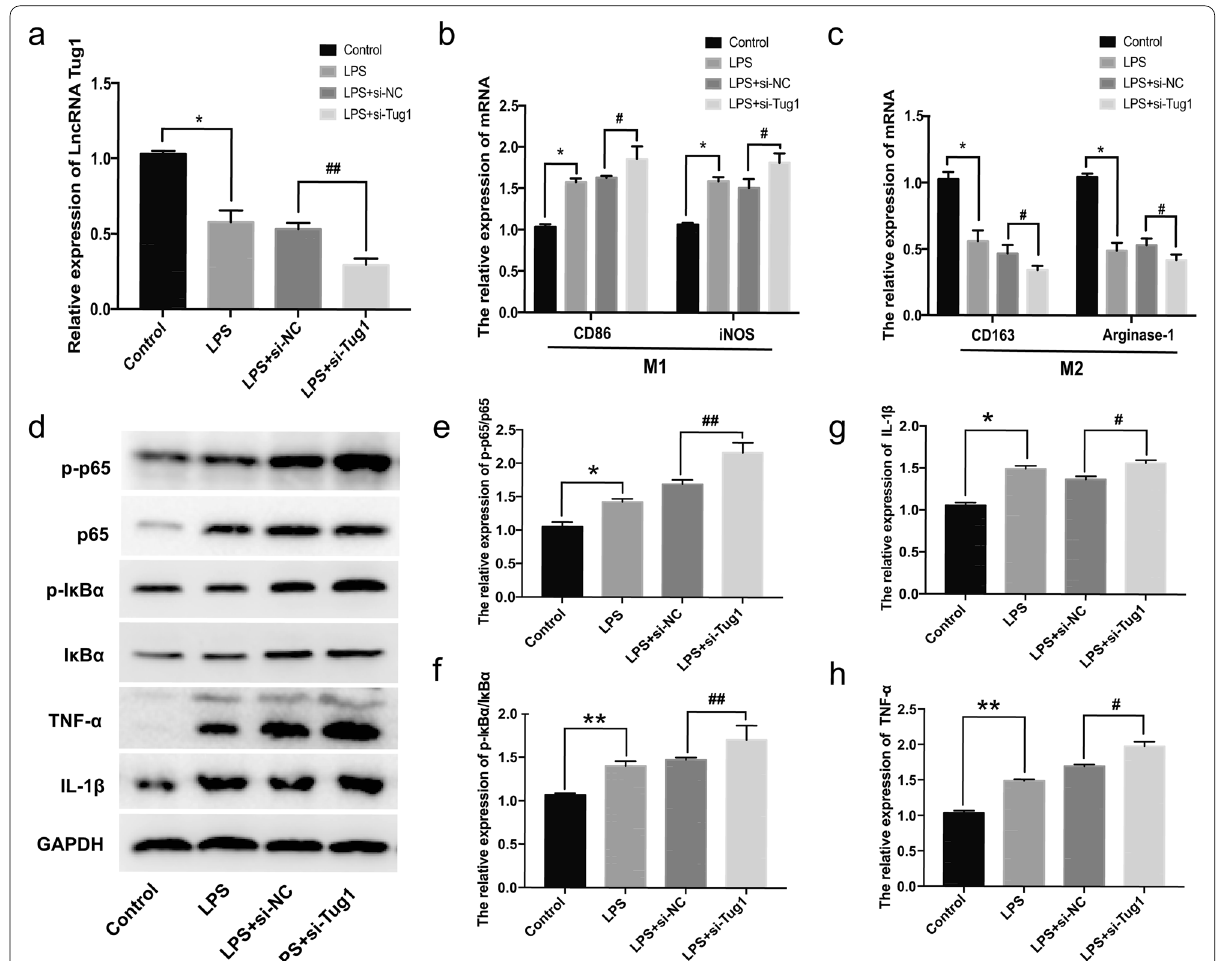
Fig. 5 Effect of Tug1 knockdown on LPS-treatment inflammation in microglia. a Knockdown of lncRNA Tug1 in microglia. b The mRNAlevel of M1-associated markers CD86 and iNOS in microglia. c The mRNA of M2-associated markers CD163 and Arginase-1 in rat microglia. d Western blotting analysis of p65, p-p65, pIκBα, IκBα, TNF-α and IL-1β in microglia. e‑h The relative protein levels of p65, p-p65, pIκBα, IκBα, TNF-α and IL-1β in microglia. (* P < 0.05, ** P < 0.01 vs. Control; # P < 0.05, ## P < 0.01 vs. LPS +